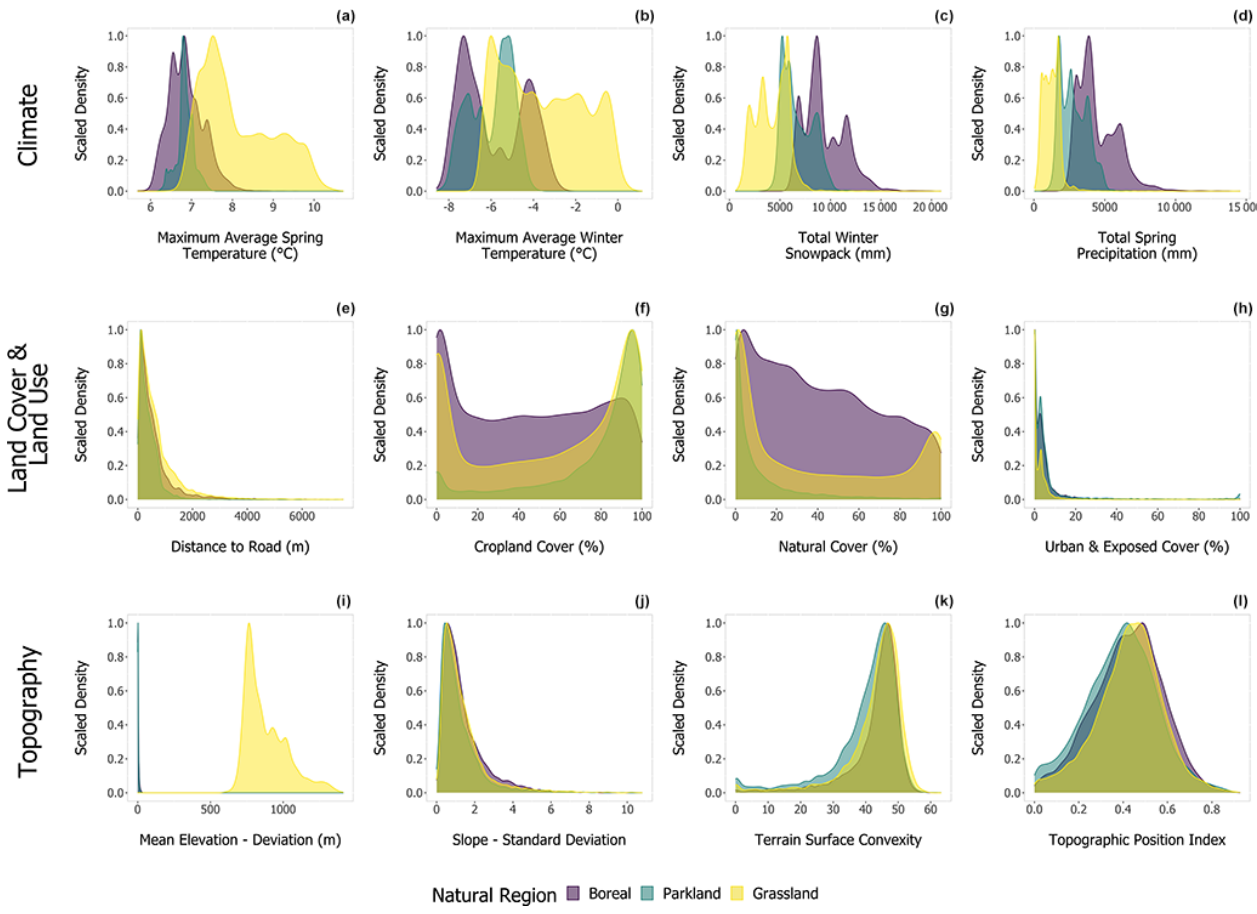
Figure 4. Frequency distribution of the top four climate, land cover and land use, and topography variables by natural